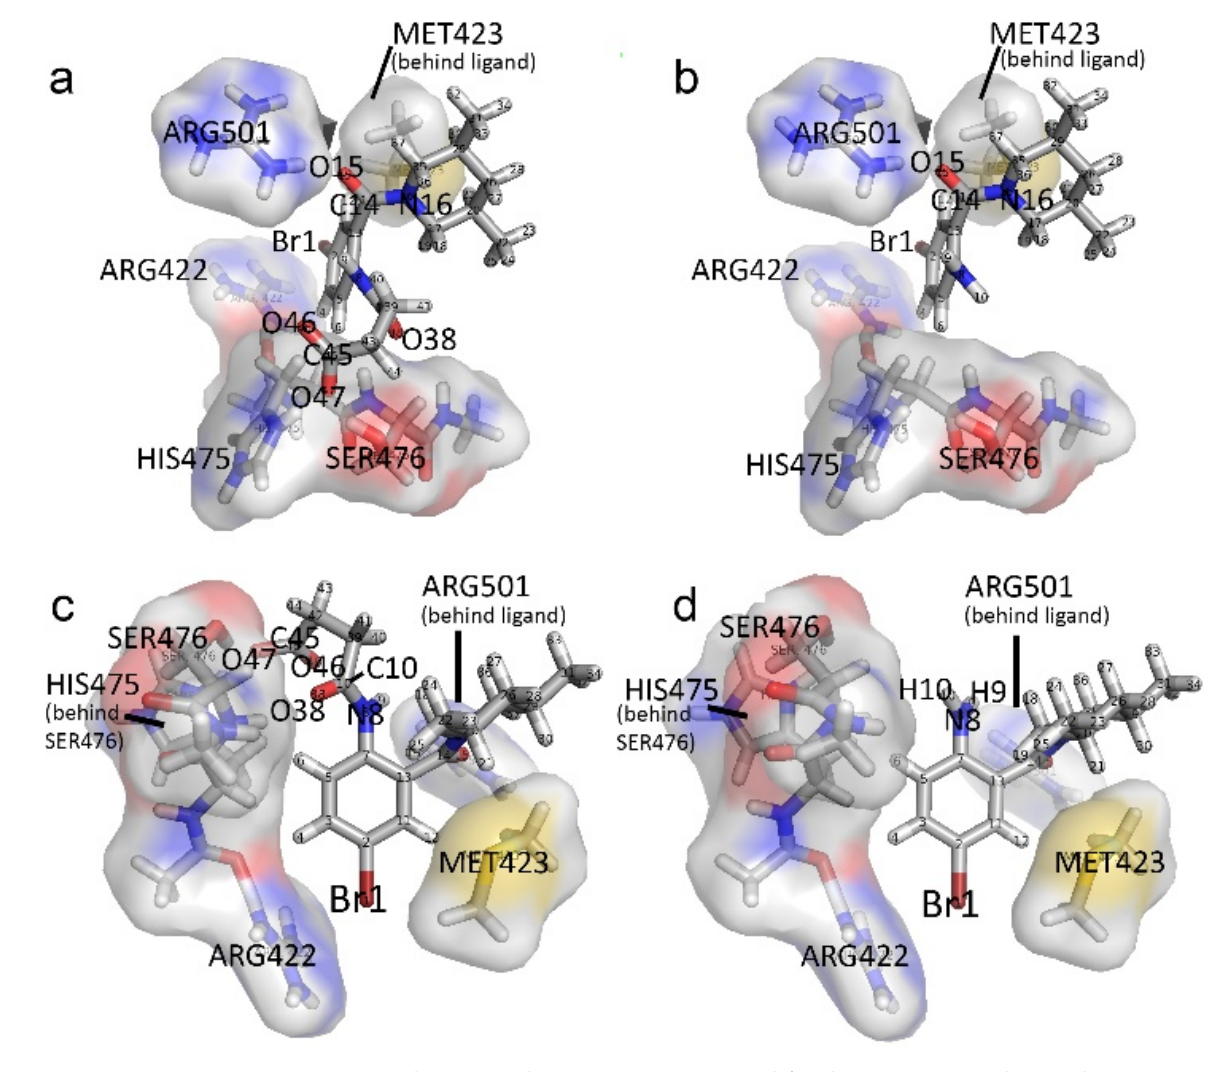
Figure 2. The 117- and 107-atom systems used for the REG-IQA analysis. The system involves five residues, three of which are charged. The residues were selected because (i) they make critical interactions with the ligand, (ii) affect the charge, and (iii) are the most important to keep the shape of the site in the model. ( a , b ) Top view of the allosteric site representation for ( a ) 3CJ4 and ( b ) 3CJ2, respectively. ( c , d ) Side view of the same systems. The Arg422 residue represents the bottom of the allosteric site.